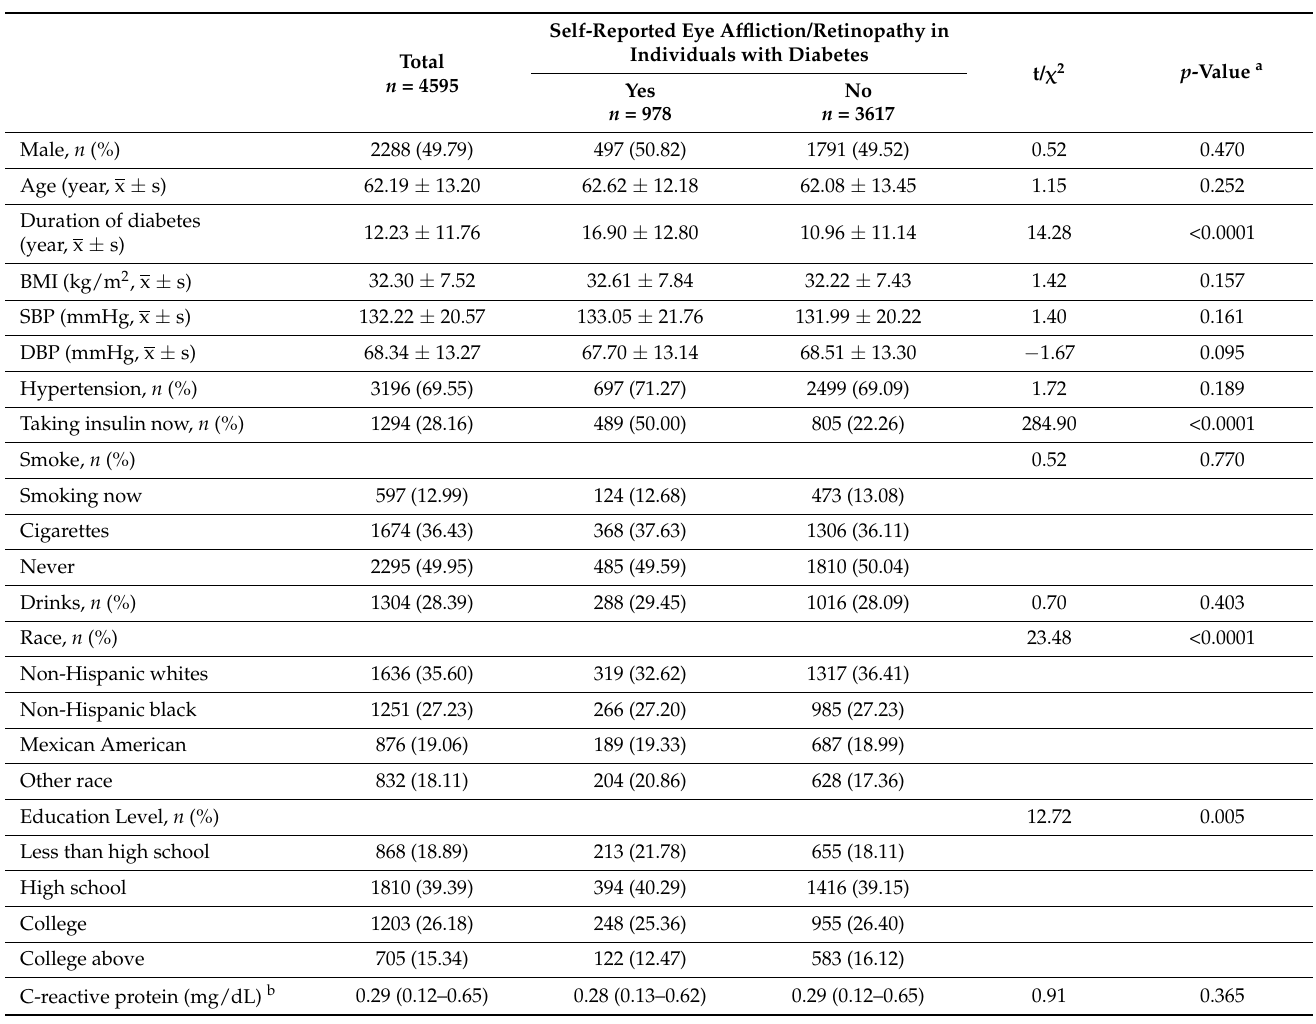
Table 1. Baseline data of study